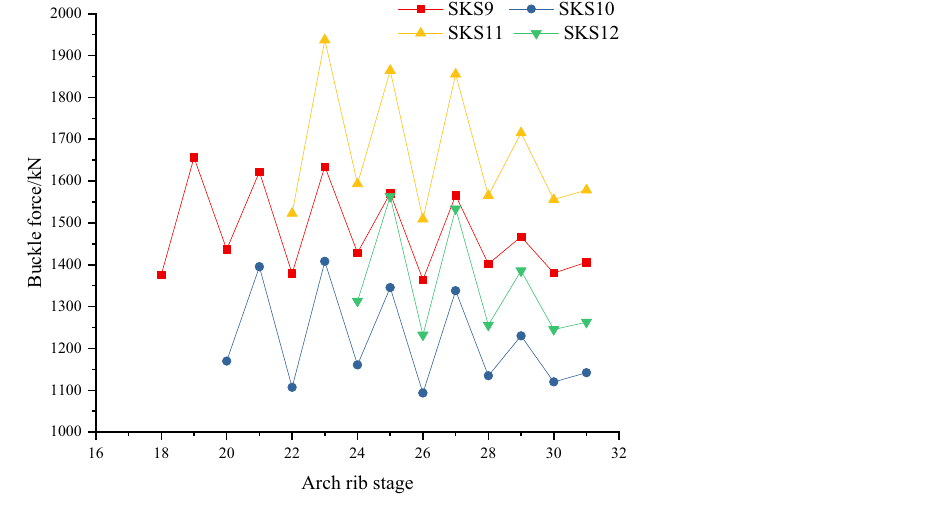
Figure 19. Variation curves of cable